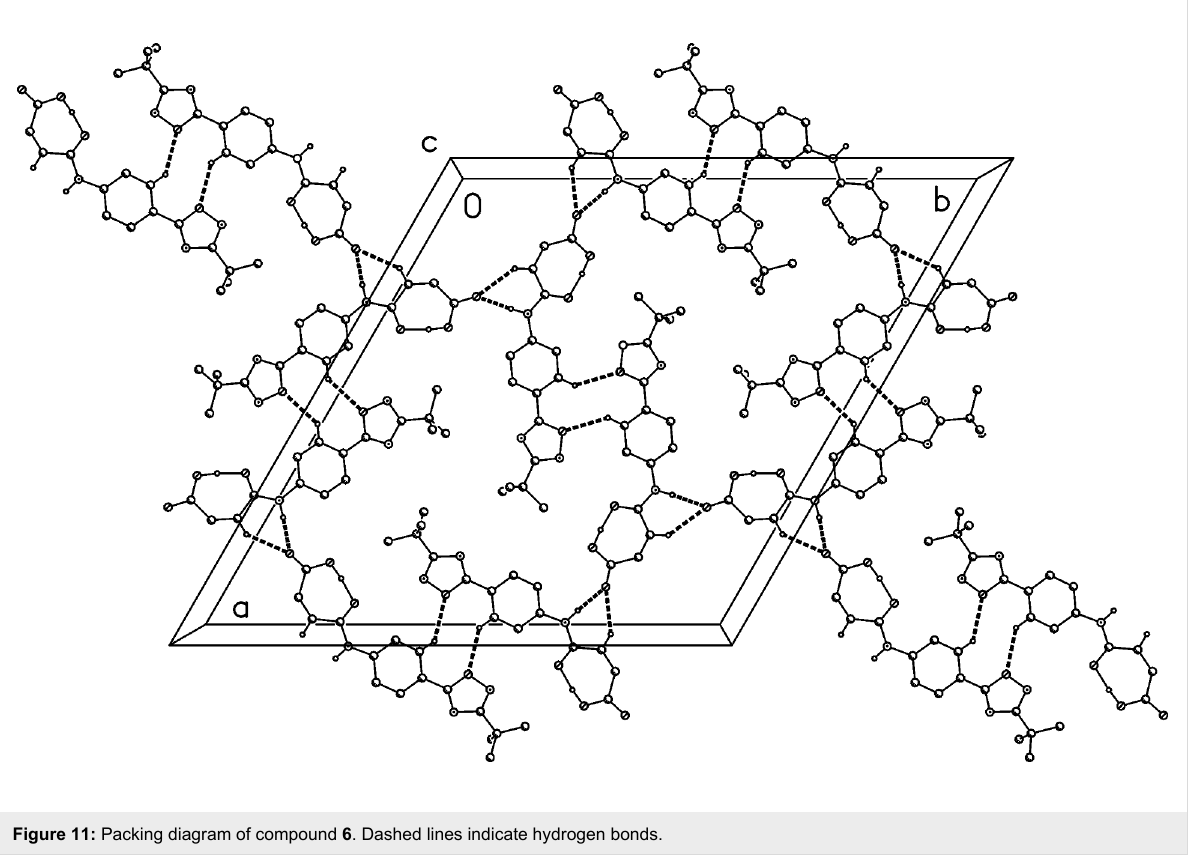
Figure 11: Packing diagram of compound 6 . Dashed lines indicate hydrogen bonds.